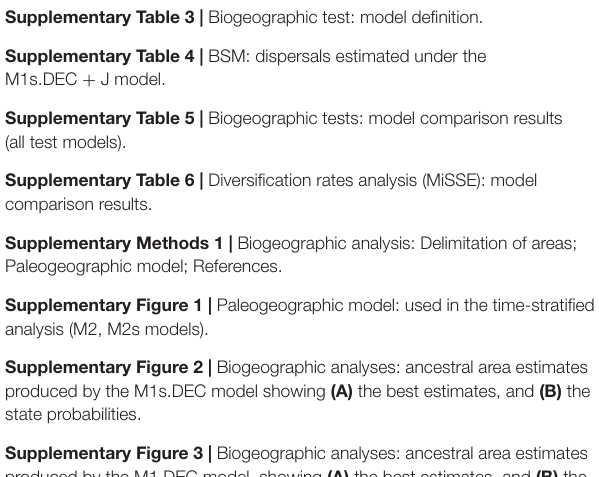
Supplementary Figure 3 | Biogeographic analyses: ancestral area estimates produced by the M1.DEC model, showing (A) the best estimates, and (B) the state probabilities. Supplementary Figure 4 | Biogeographic analyses: ancestral area estimates produced by the M1.DEC + j model, showing (A) the best estimates, and (B) the state probabilities.